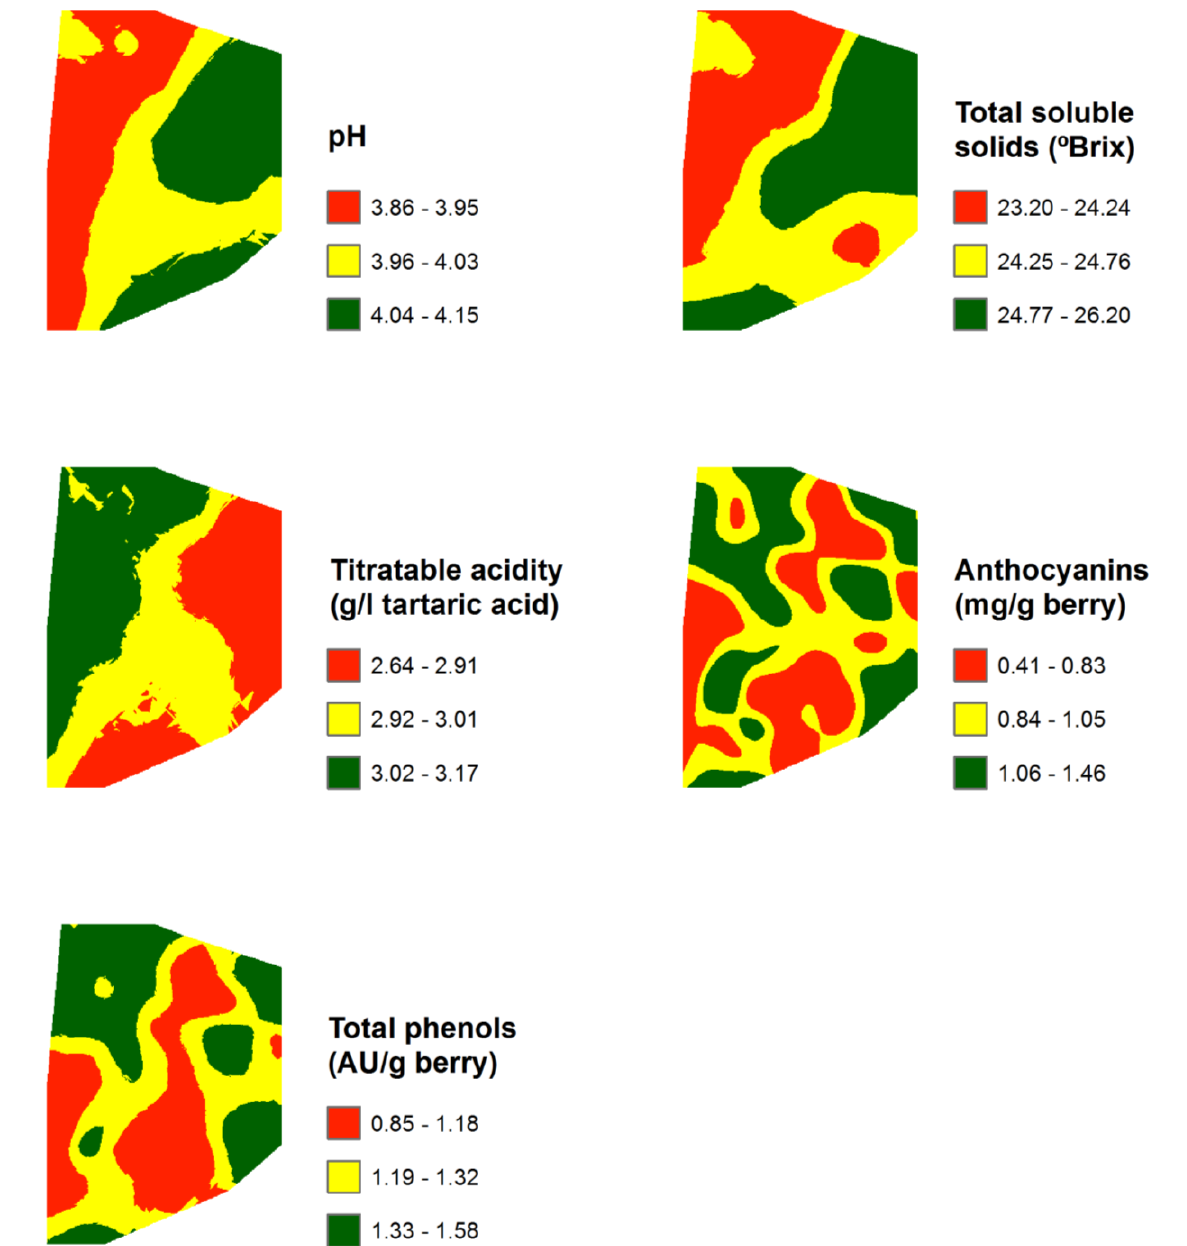
Figure 6. Maps obtained for grape quality parameters (pH, total soluble solids, Titratable acidity, anthocyanins, and total phenols) in a Tempranillo ( Vitis vinifera L.) vineyard. Maps were represented by terciles. AU: absorbance